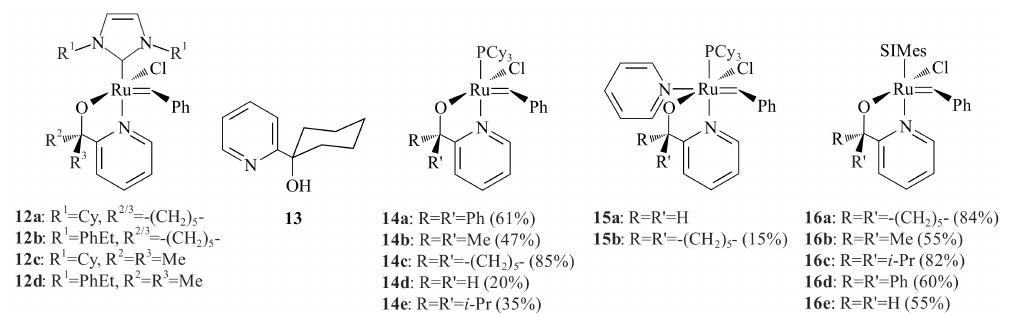
Figure 4. Pyridinyl alcoholato ruthenium carbene